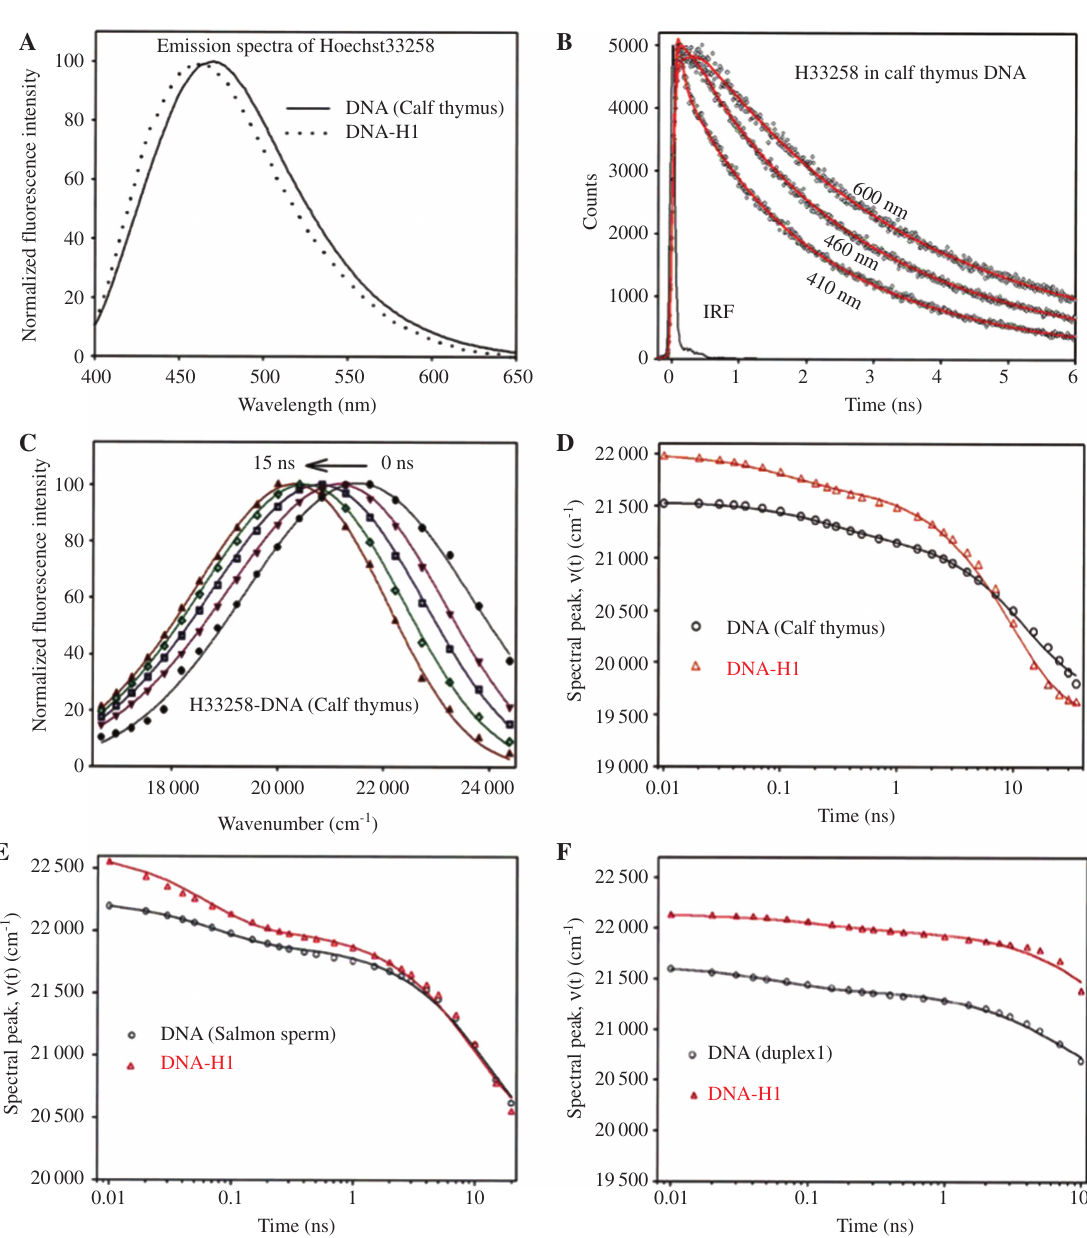
Figure 2 Solvation relaxation of H33258 in DNA and in DNA-Histone complex. (A) Steady-state emission spectra of H33258 in calf thymus DNA and the DNA-H1 complex. (B) Fluorescence transients of H33258-calf thymus DNA at three different detection wavelengths. (C) Time-resolved emission spectra of H33258 in calf thymus DNA. Time-resolved fluorescence spectral peak frequency of H33258 in (D) calf thymus DNA and DNA-H1 complex, (E) salmon sperm DNA and its condensate, and (F) duplex1 and duplex1-H1 complex are shown. Solid lines indicate biexponential numerical fitting of the experimental data points. [Reprinted with permission from ref. (22) Copyright 2007, American Chemical